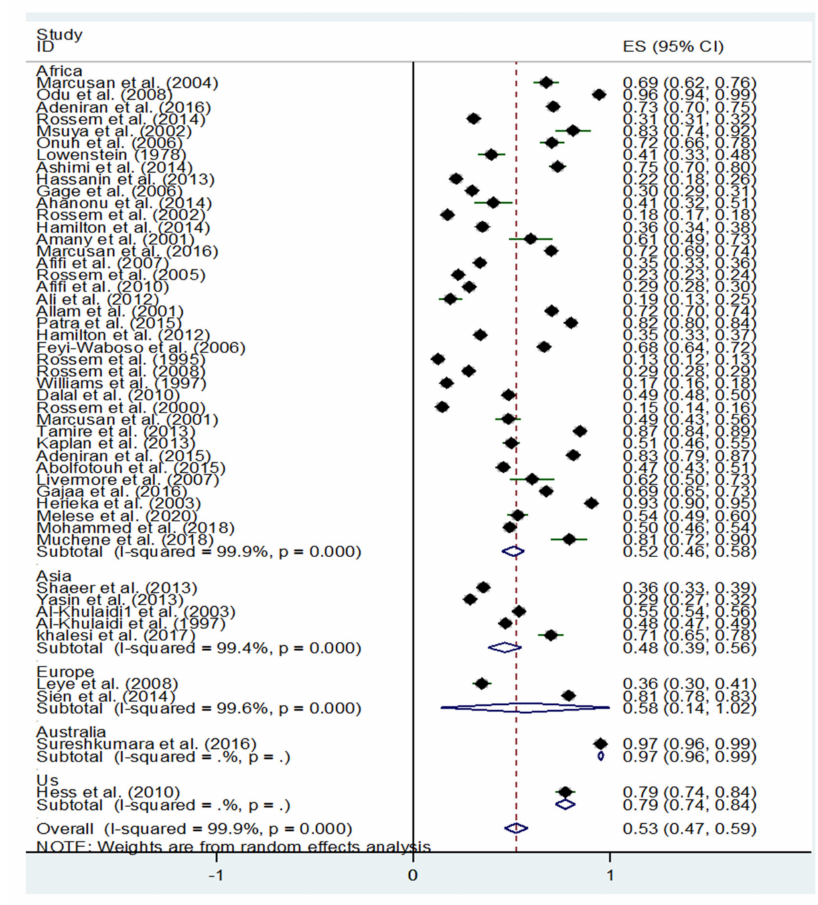
Figure 2. Negative attitudes toward